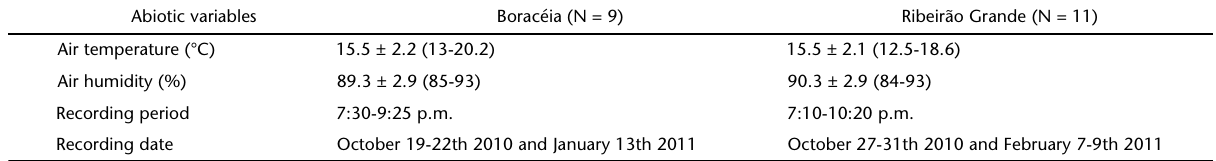
Table 1. Abiotic conditions during call recordings of Dendropsophus microps in the two localities. Values presented as mean ± standard deviation (range). Abiotic